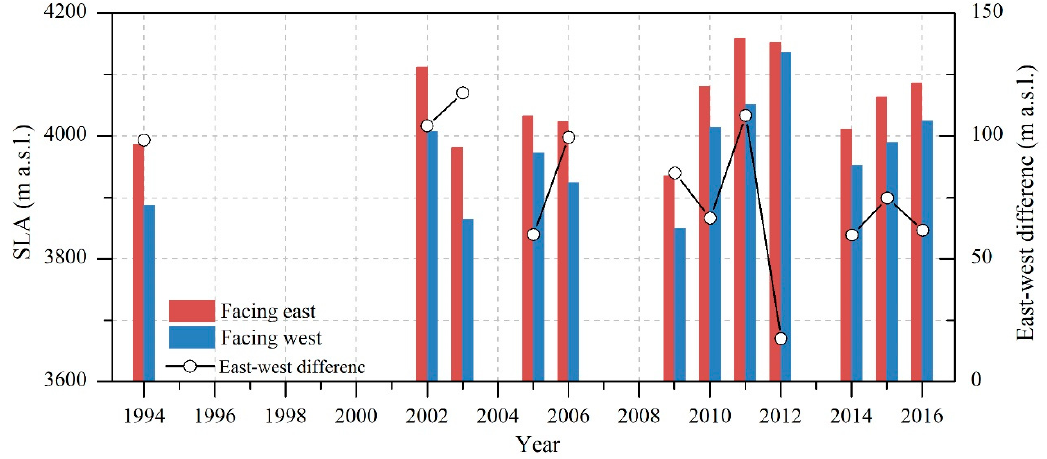
Figure 9. The annual mean snow line altitude (SLA) on the eastern and western slopes and their differences during 1994 ‒ 2016.